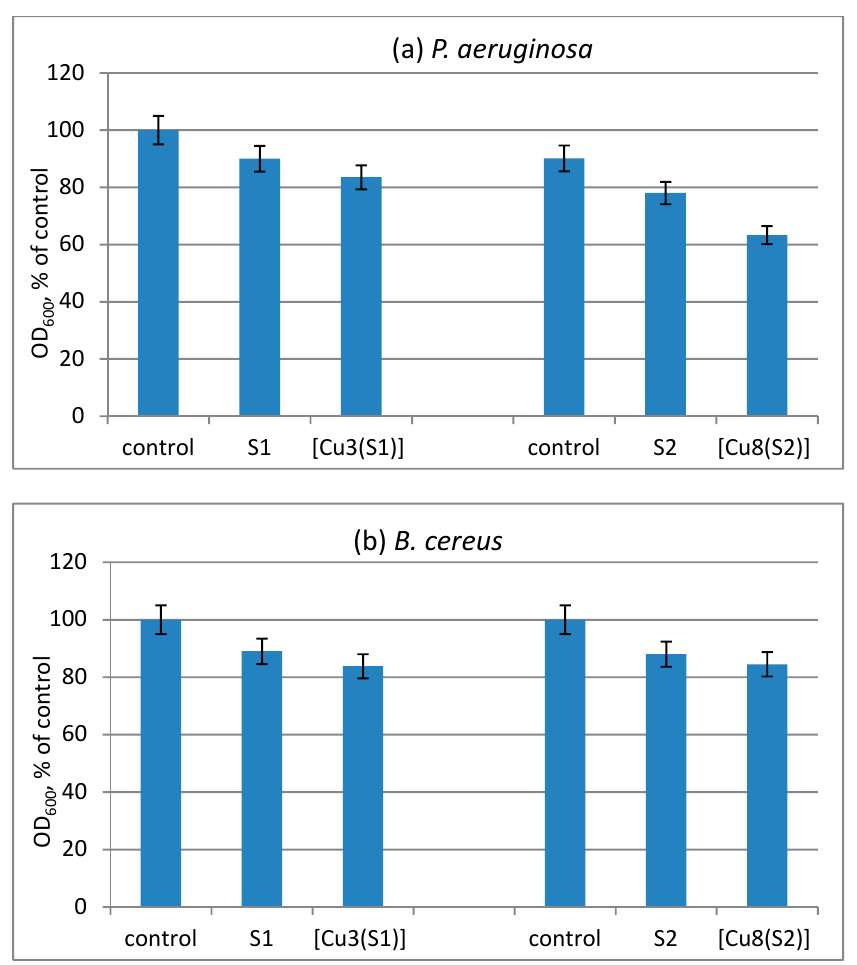
Figure 5. Reduction of the growth of model bacteria P. aeruginosa ( a ) and B. cereus ( b ) by the virgin and treated cotton fabrics.